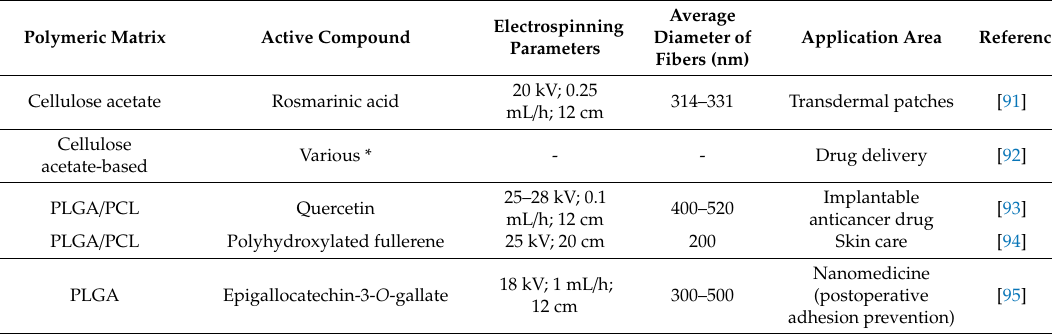
Table 6. Nanofibers with antioxidant-related